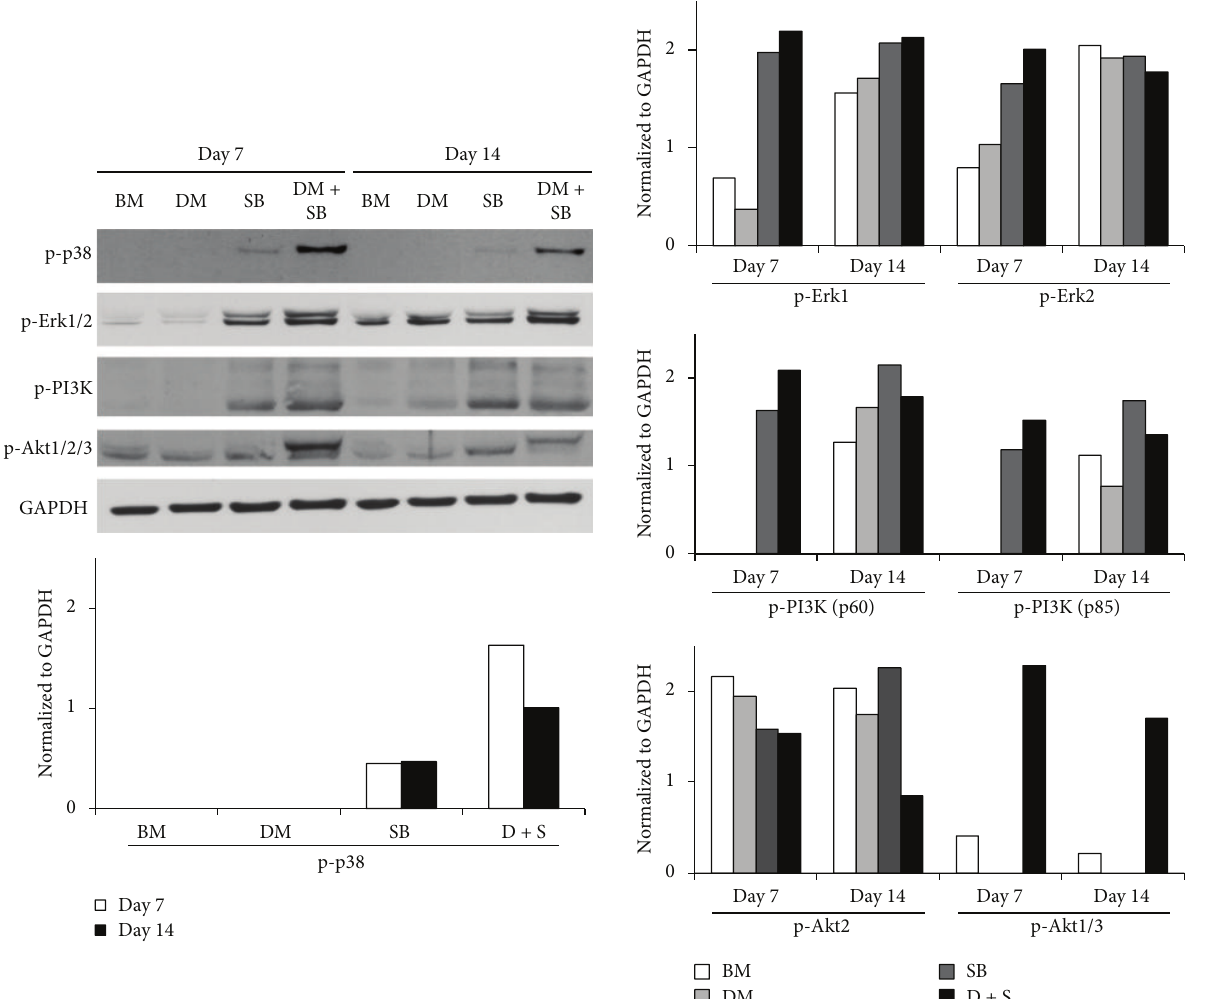
Figure4:Dualinhibitionofactivin/nodal/TGF- 𝛽 andBMPsignalingpathwaysinhADSCsactivatesp38,Erk1/2,PI3K,andAkt1/2/3.hADSCs were grown in BM or BM supplemented with either activin/nodal/TGF- 𝛽 pathway inhibitor SB or BMP pathway inhibitor DM or both for 7 and 14 days. The cells were harvested after 7 and 14 days and total proteins were harvested using extraction reagent. Proteins were resolved using electrophoresis and were transferred onto a nitrocellulose membrane using Trans-Blot cell. The bands were visualized by incubating the membrane with specific monoclonal antibodies followed by incubation with HRP-conjugated secondary antibody and then that with ECL reagent containing the substrate and enhancer solution. Intensity of bands was quantified using ImageJ